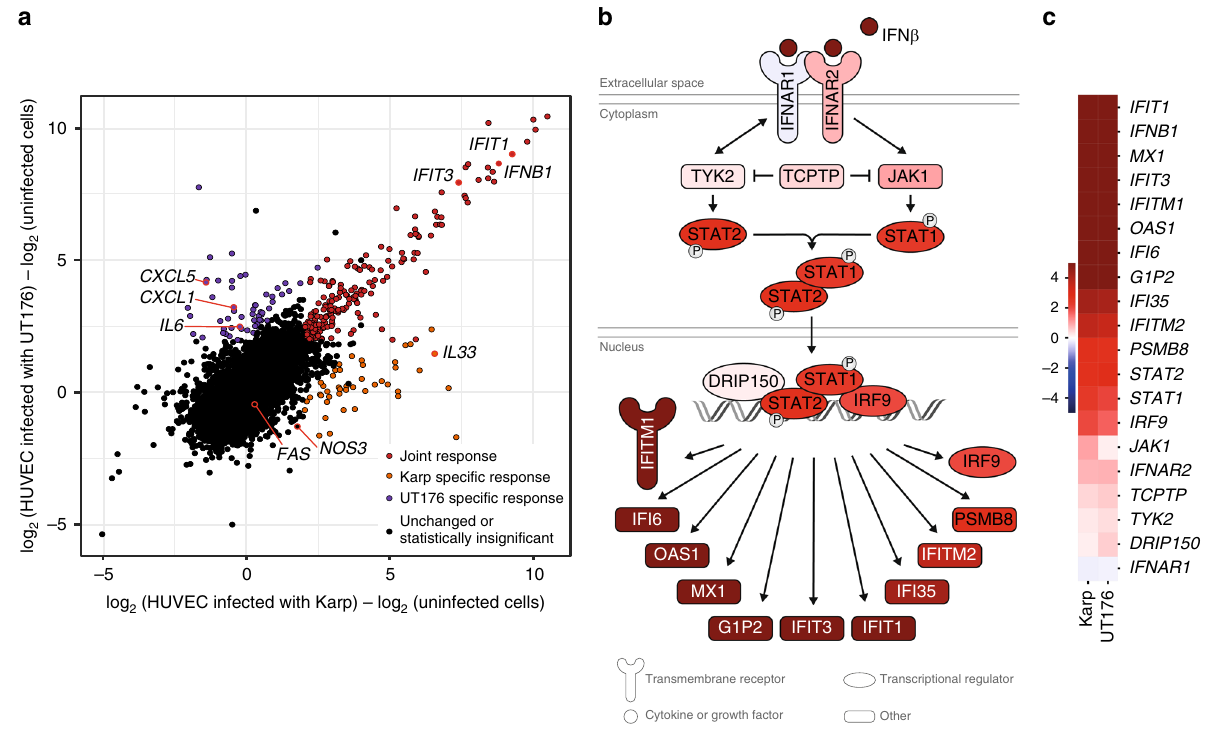
Fig. 5 Ot induces an antiviral interferon response in HUVECs. a Summary of the host response showing joint and strain-speci fi c responses. The joint response is de fi ned as genes with a log 2 fold change (logFC) > 2 and FDR-corrected p -value < 0.01 for infection with both Karp and UT176. Strain-speci fi c responses are genes with a logFC > 2 and FDR-corrected p -value < 0.01 for infection with either Karp or UT176, excluding genes already included in the joint response. FDR-corrected two-sided p -values were calculated using the quasi-likelihood F -test in the edgeR R package. b Activation of multiple genes in the canonical interferon signaling pathway in Karp-infected HUVECs compared with uninfected HUVEC cells. c Heatmap showing upregulation of genes in the interferon signaling pathway in HUVEC cells infected with Karp and UT176 compared with uninfected cells. The color scale represents the logFC in gene